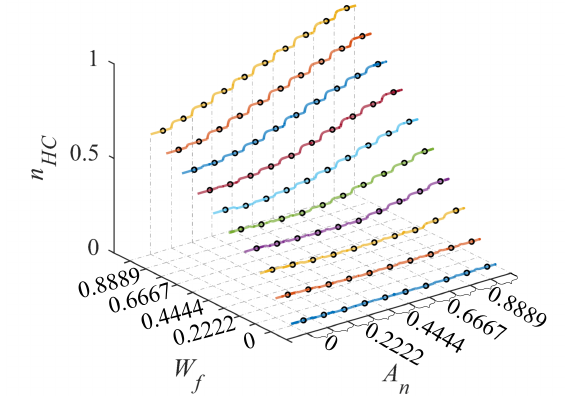
Figure 2. The simulation results of n HC under ten simulation conditions.